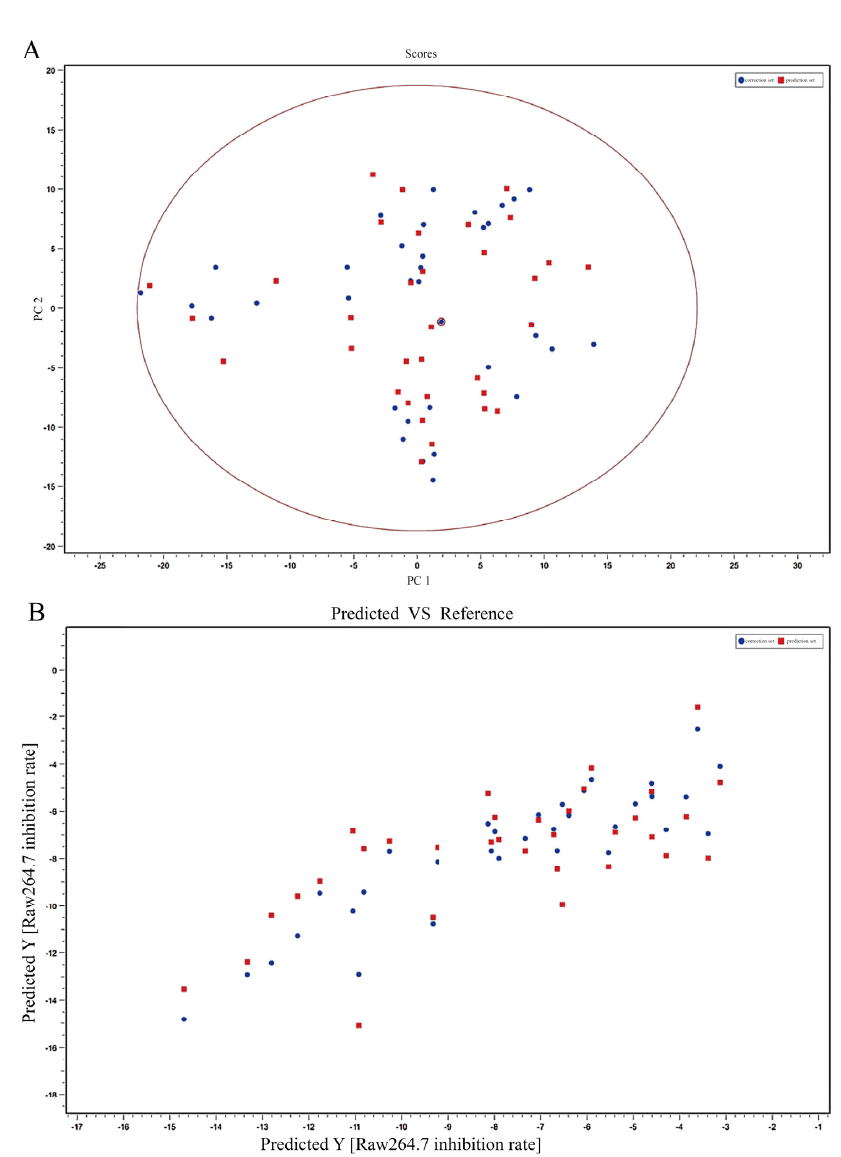
Figure 7. The spectral-effect relationships between the chemical composition and anti-inflammatory activity of T. hemsleyanum extracts from different origins on IL-1 β expression in the LPS-induced RAW264.7 inflammation model. PCA scores of metabolites of T. hemsleyanum extracts with respect to the IL-1 β expression ( A ); PLS modeling of metabolites of T. hemsleyanum extracts with respect to the IL-1 β expression ( B ).